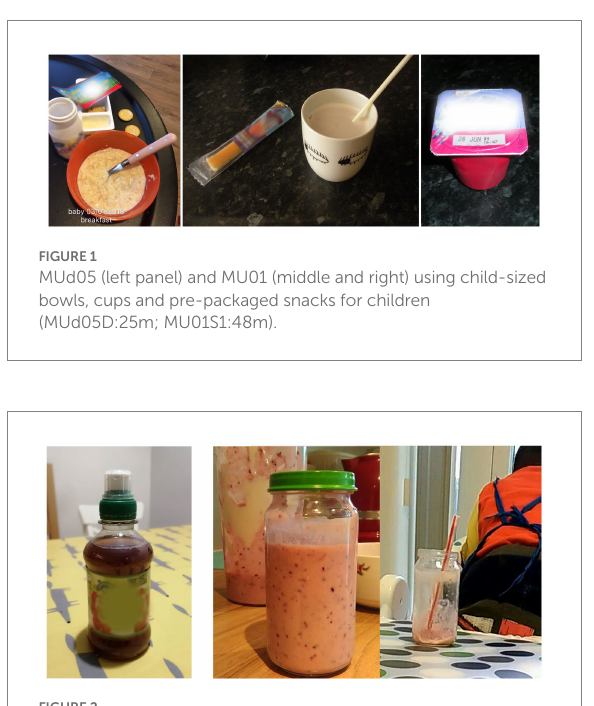
FIGURE 2 Reuse of children’s food packaging.